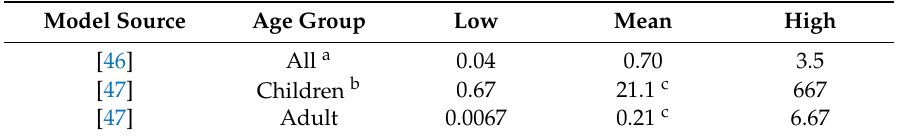
Table 2. Initial fecal shedding rate (mg / bather /